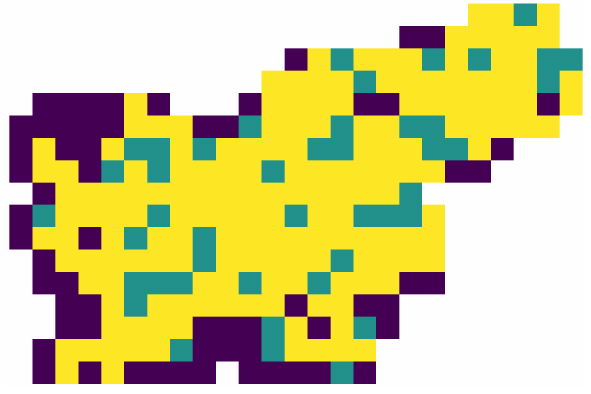
Figure 2. Data separation.